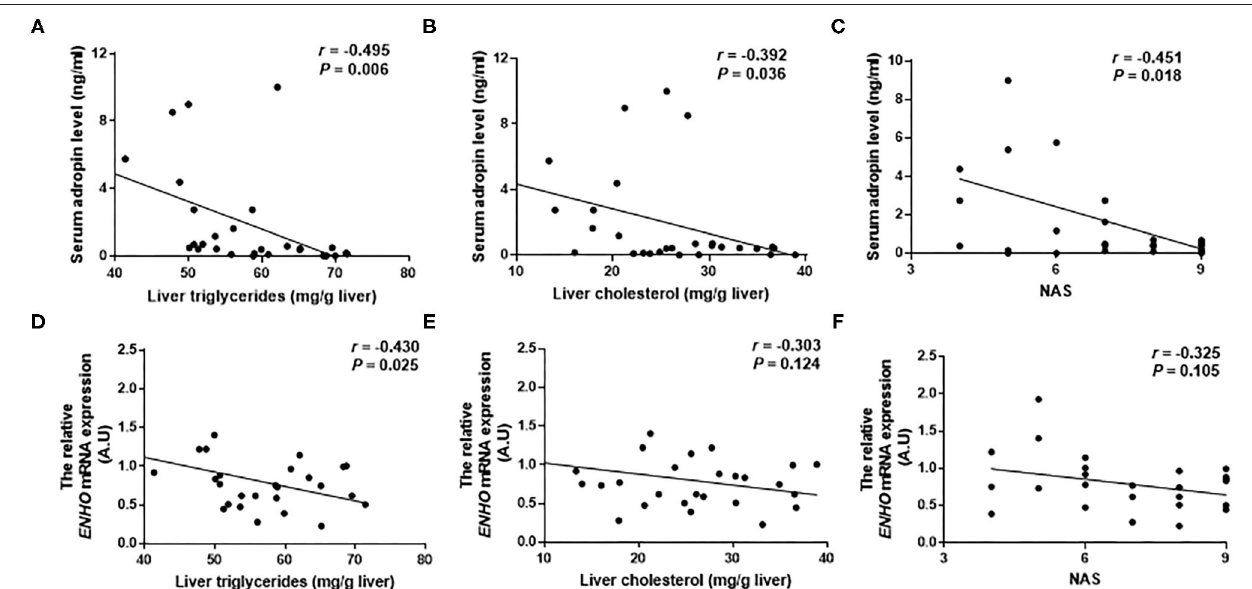
FIGURE 4 | The correlation between serum adropin/liver adropin levels and the level of liver triglycerides (A,D) , and liver cholesterol (B,E) , and NAFLD activity score (C,F) in MAFLD